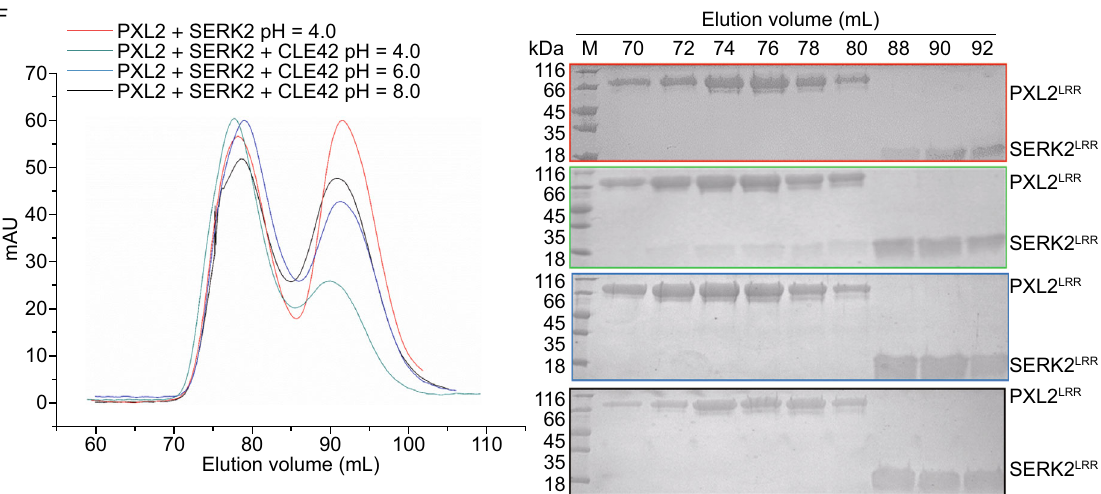
structures of PXL2 LRR and PXY LRR and high sequence identity between CLE41 and CLE42 (Fig. 2B). In the mod- eled structure of PXL2 LRR -CLE42, the small peptide also adopts an “ Ω ” -like kink to interact with PXL2, forming a set of interactions (Fig. 2C – E) conserved in the PXY LRR -CLE41 interaction. The total buried surface areas generated by CLE42 binding to PXL2 LRR and CLE41 to PXY LRR are similar to each other. However, the non-polar buried surface area in